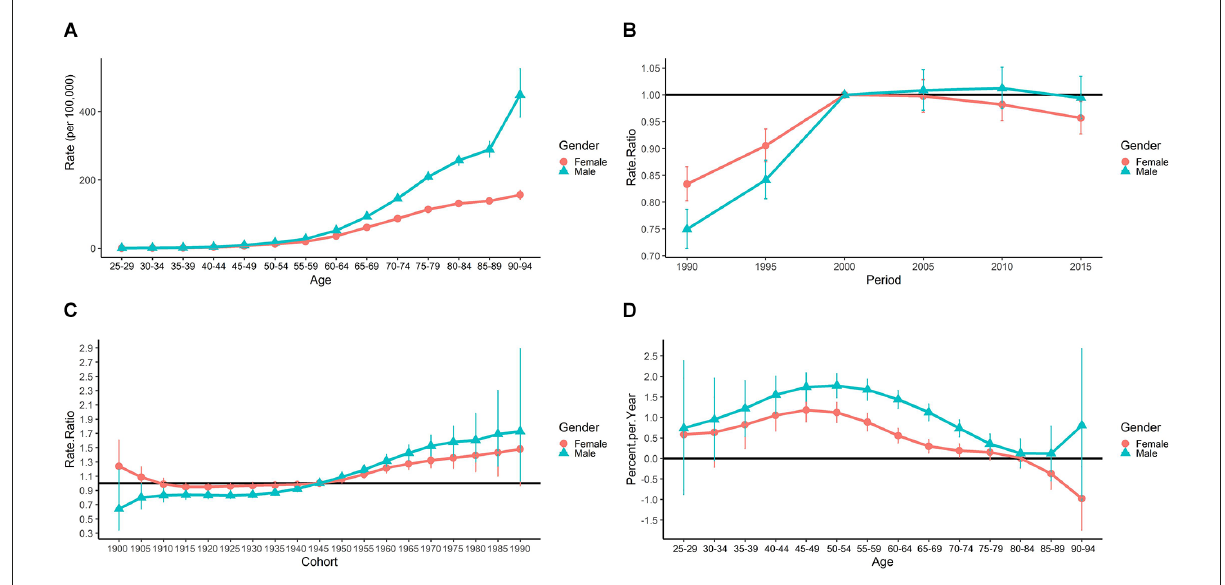
FIGURE1 Results of APC analysis for PD incidence from 1990 to 2019. (A) Longitudinal age curve of PD incidence (per 100,000) by gender. (B) Period RR by gender. (C) Cohort RR by gender. (D) Local drifts by gender.